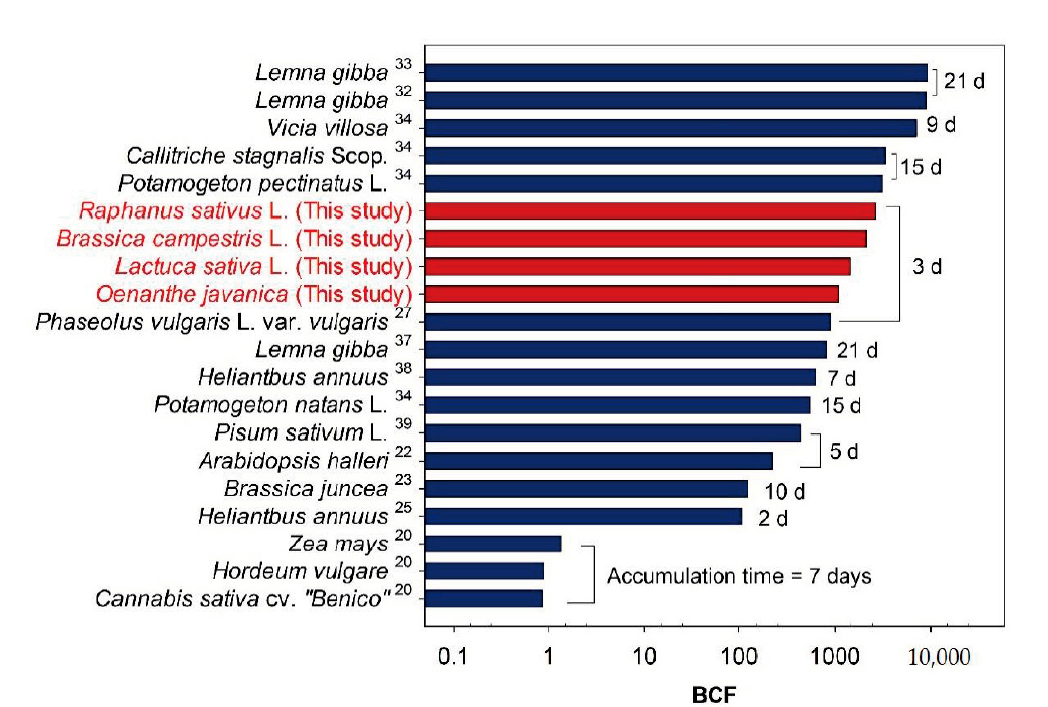
Figure 6. Average uranium BCFs of various plants after rhizofiltration experiments using artificially contaminated solution. The BCF values and accumulation times were obtained from previous studies.